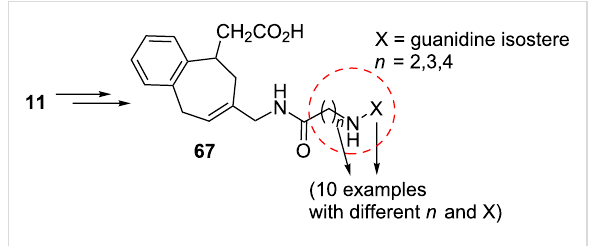
Figure 4: A novel series of benzo[7]annulenes prepared from 4,5- benzotropone ( 11 ).